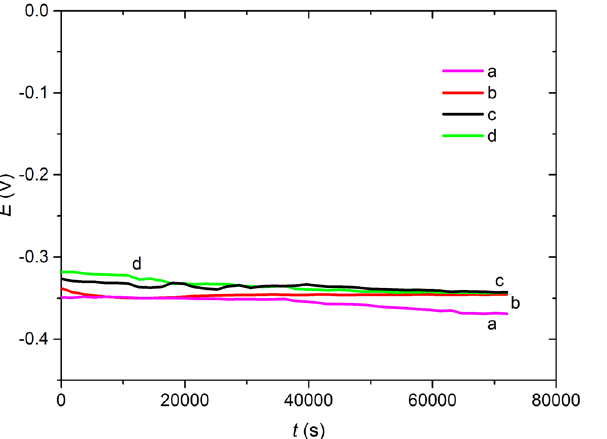
Figure 5: Dependences of E = f ( t ) for the coatings: Ni – 18.7Re ( a ) , Ni – 32.7Re ( b ) , Ni – 35.3Re ( c ) , and Ni – 37Re ( d ) .